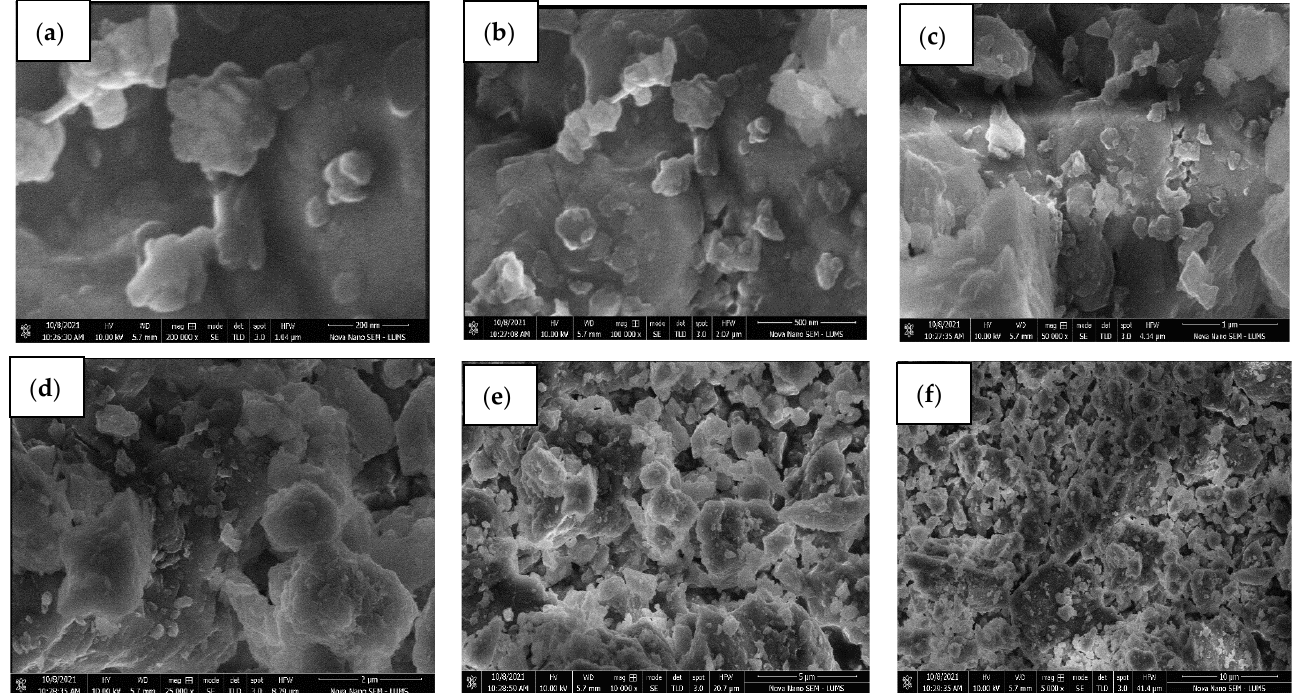
Figure 8. SEM images of sodium metasilicate treated golden marble powder at various resolutions,